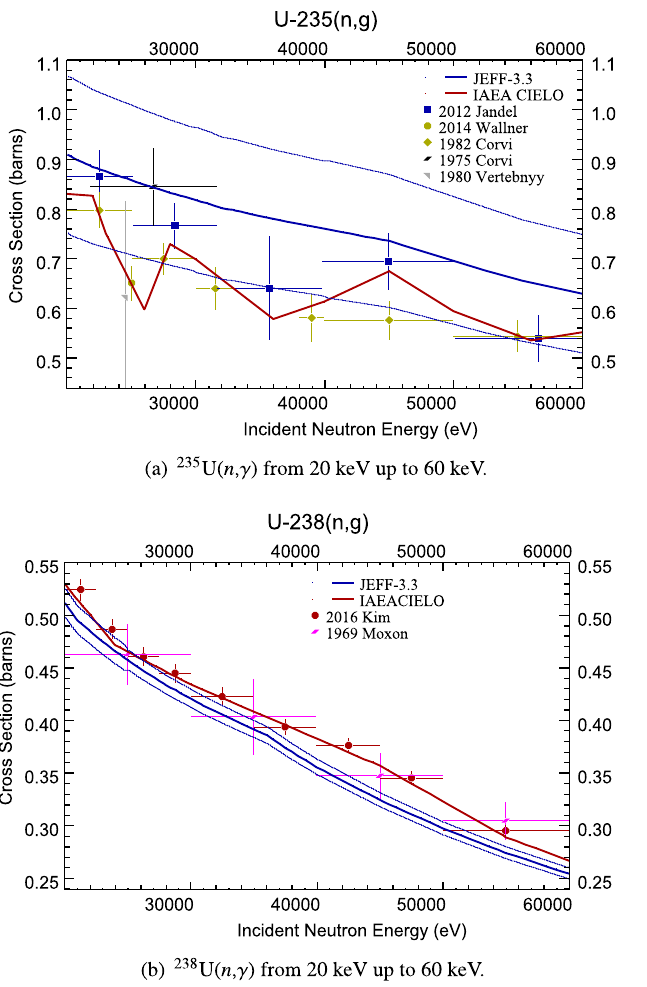
Fig. 4. Evaluated capture cross sections on 235 U and 238 U targets in the region relevant to the calculation of the MACS at (30 keV) are compared to experimental data retrieved from EXFOR [20]. (a) 235 U( n , g ) from 20 keV to 60 keV, (b) 238 U( n , g ) from 20keV to 60 keV.